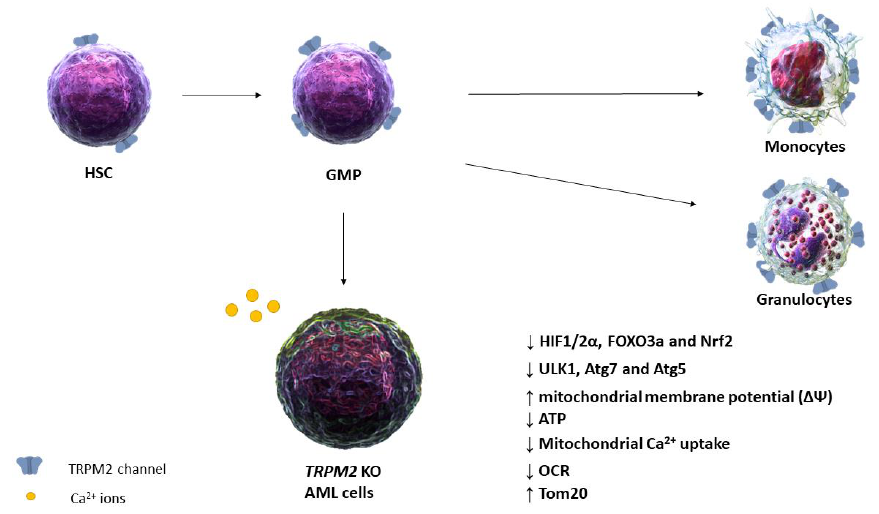
Figure 2. TRPM2 depletion has been correlated with the impairment of several pathways essential for the survival of leukemic cancer cells, suggesting TRPM2 as a strategic therapeutic target [48,49,70]. Abbreviations: HSC, hematopoietic stem cells; GMP, granulocyte-macrophage progenitors; AML, acute myeloid leukaemia; TRPM2, transient receptor potential melastatin 2; HIF 1/2α, hypoxia-inducible factor 1/2α; FOXO3a, forkhead box O3a; Nrf2, nuclear factor erythroid 2–related factor 2; ULK1, Unc-51 like autophagy activating kinase 1; Atg7, autophagy-related 7; Atg5, autophagy-related 5; ATP, adenosine triphosphate; OCR, oxygen consumption rate; Tom20, translocase of outer membrane 20; KO, knockout; ( ↑ ) increment; ( ↓ ) reduction.